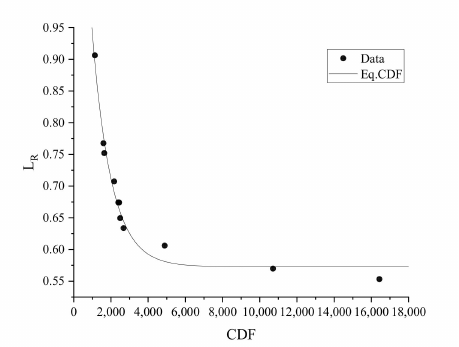
Figure 3. CDF curve of p -TsOH fractionation with rice straw.